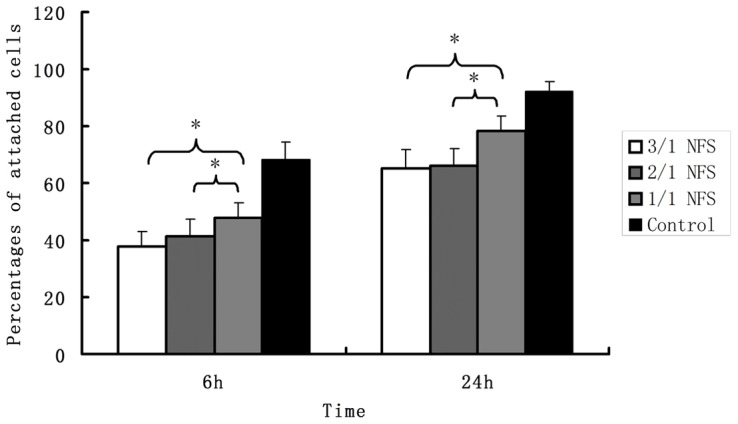
The percentages of attached hASCs on different NFS.The attachment percentage of 1/1 NFS group was obviously more than 3/1 NFS and 2/1 NFS whether at 6 h or 24 h. (all p<0.05 when pairwise compared). The control hASCs, having the highest attachment percentage without doubt, was not necessary to be included in the statistical analysis already. * indicated there was a statistically significant difference between the two groups connected by a bracket.